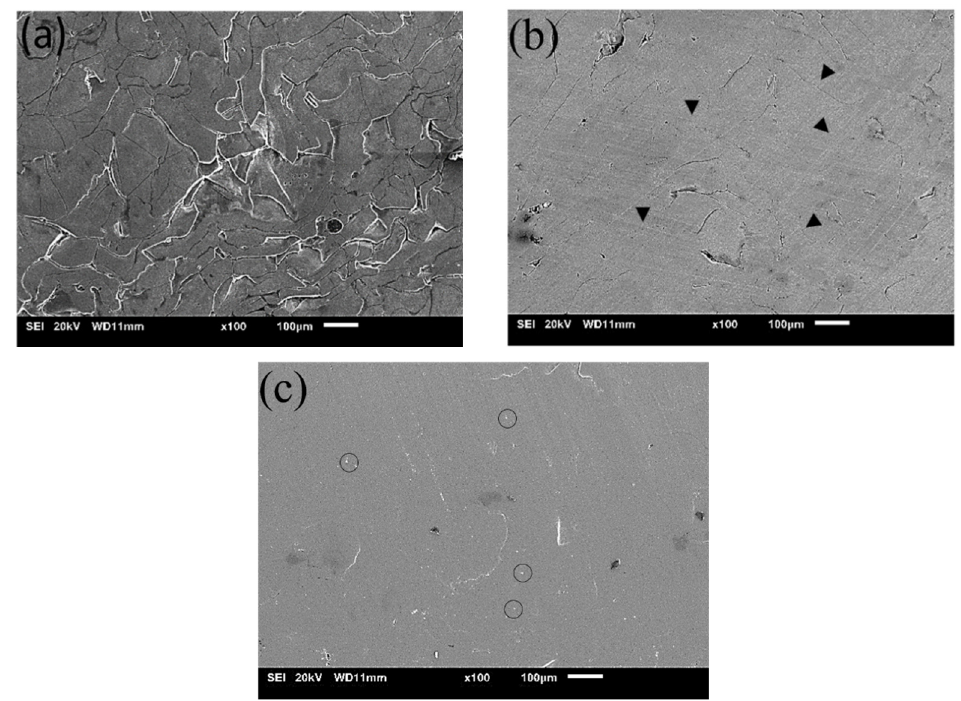
Figure 3. SEM micrographs of ( a ) pre-SPS Mg-Zn-Ca BMG and SPS Mg-Zn-Ca BMG at ( b ) 150 °C and ( c ) 160 °C with melt spun ribbons at 60 MPa